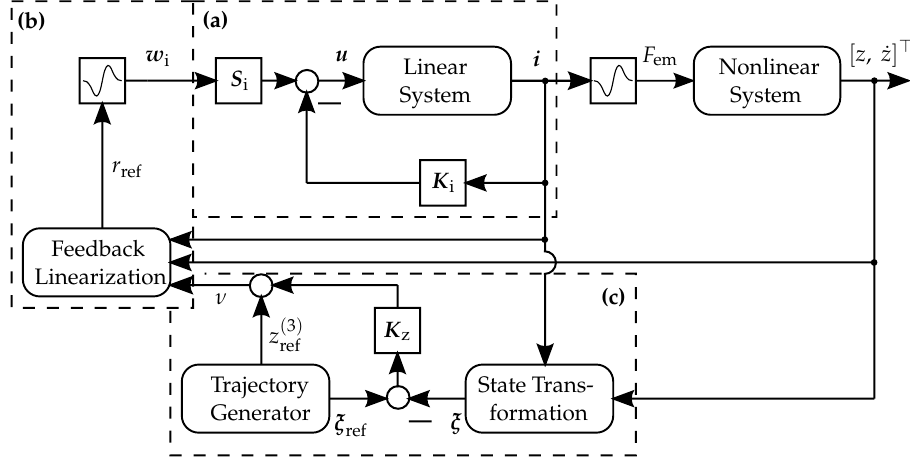
Figure 2. Combination of cascade control and flatness-based control. The linear partial system, i.e., the solenoids, are controlled by linear state feedback with controller gain matrix K i and prefilter S i ( a ) and the nonlinear system is handled using a feedback linearization approach ( b ). A trajectory generator is used to compute optimal reference motions and deviations between the current state and reference are compensated by a second linear controller with controller gain K z ( c